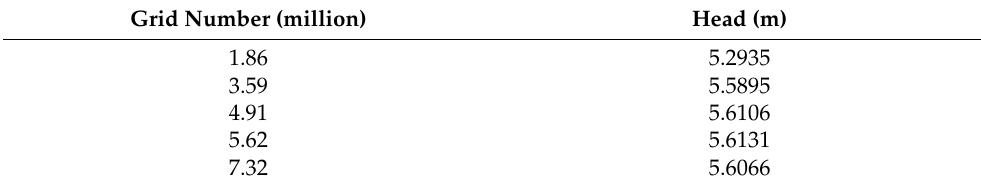
Figure 2. General and refined mesh of computational domains. ( a ) Impeller grid, ( b ) Guide vane grid, ( c ) Mesh refinement in rim region. Table 2. Calculation of head under different grid numbers.